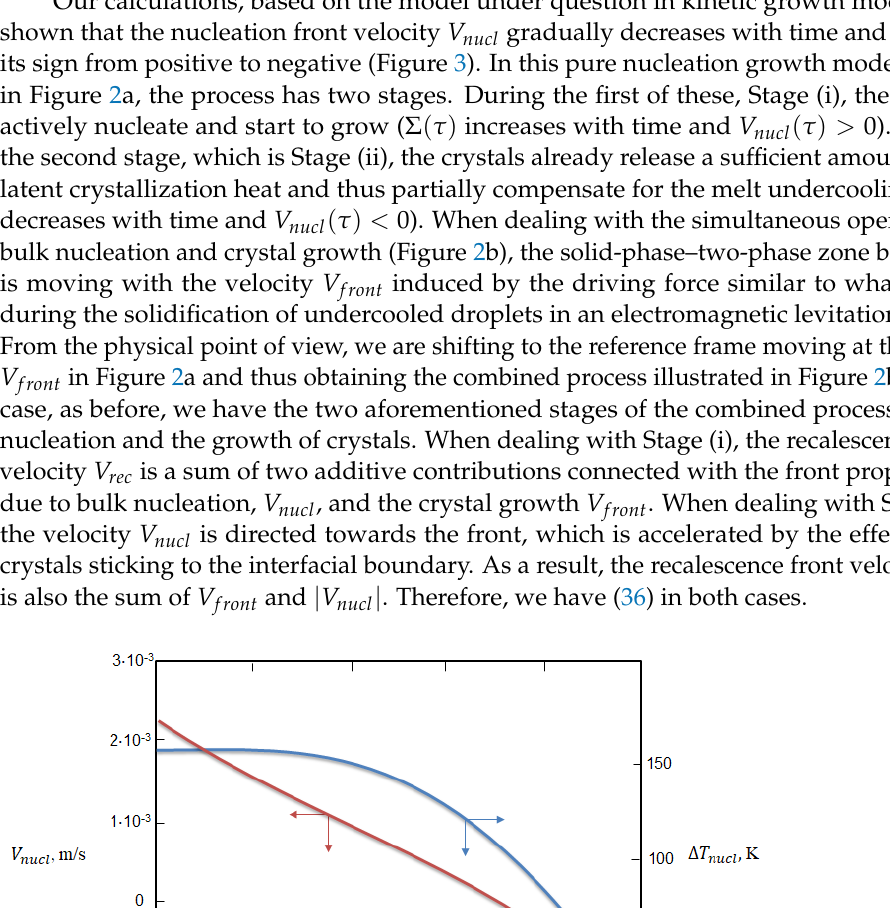
= 2.1 s, ζ = 10 − 4 m, ε = 0.1, α = 52.46, 0